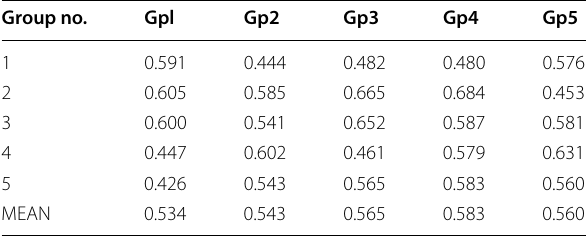
G3 (L. Acidophillus , G4 L. casei , G5 L. lactis , Gl (positive control, L . Plantarum ), G2 (control, no bacteria)